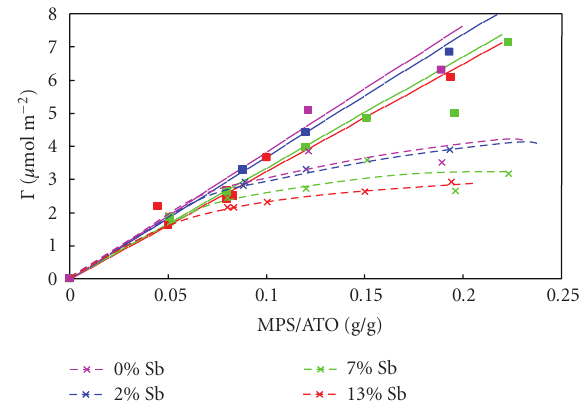
Figure 5: Amount of MPS grafted on the surface of the Sb:SnO 2 (ATO) nanoparticles (crossings) as a function of the MPS/Sb:SnO 2 ratio used in the grafting reaction. The solid lines and squares are the total amount of MPS added to the starting grafting mixture. The crossings are the grafted MPS amounts on the Sb:SnO 2